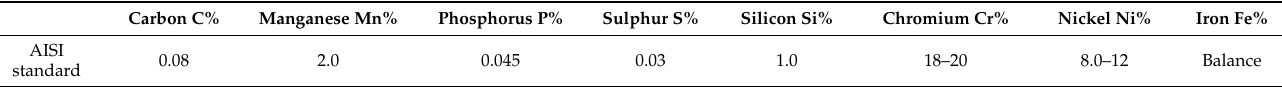
Table 2. Typical elemental composition, in wt.%, of AISI 304 type austenitic stainless